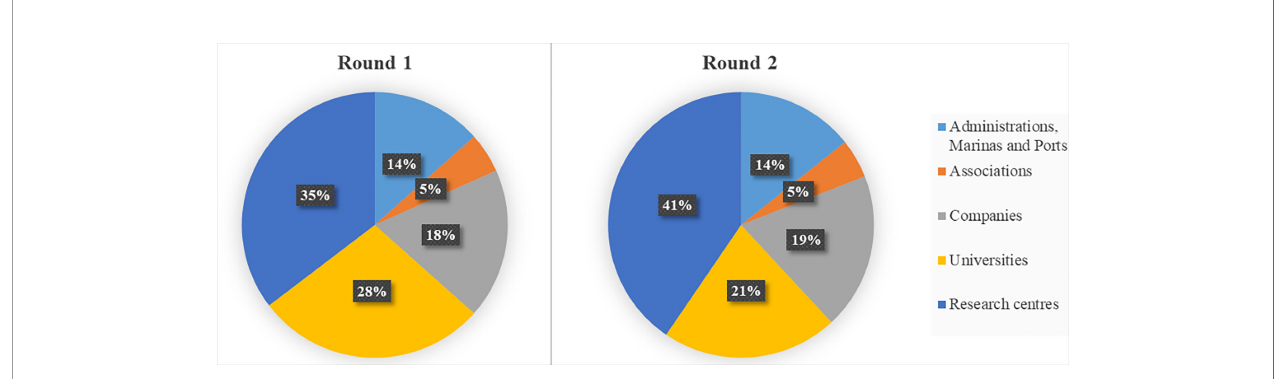
FIGURE 4 | Percentage of responses by institutions in round 1 and